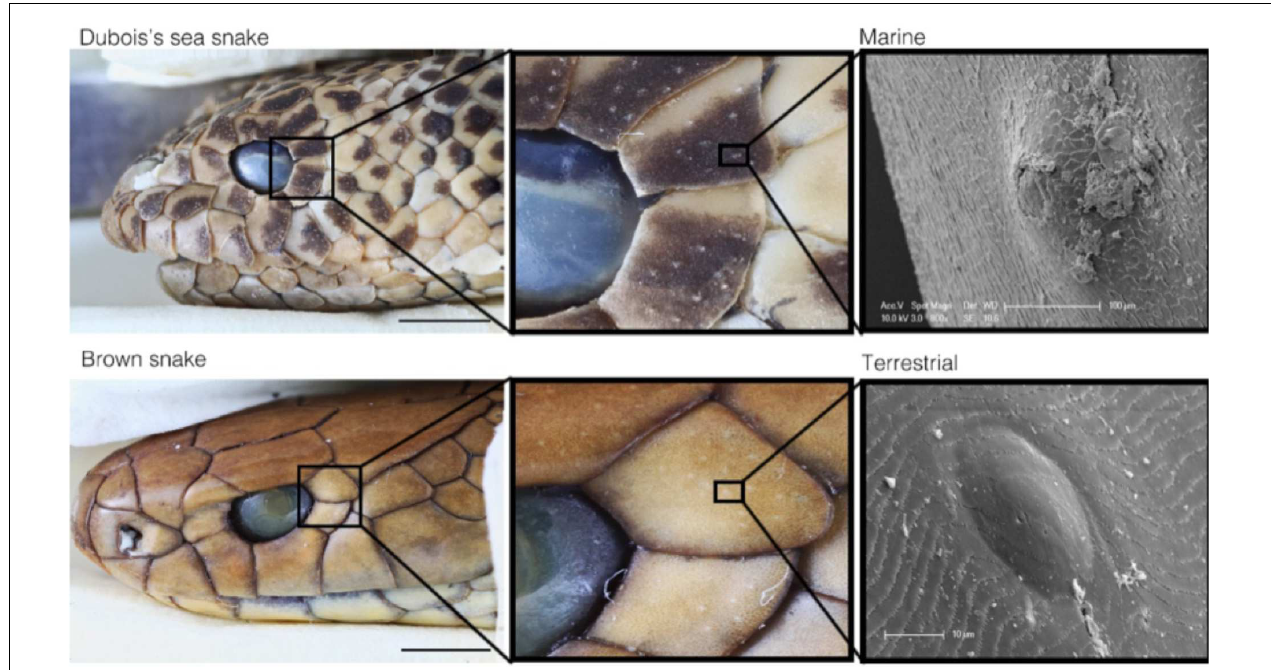
FIGURE 3 | Comparison of small scale organs, termed ‘scale sensilla,’ in fully-marine Aipysurus duboisii (top) and a close terrestrial relative Pseudonaja textilis (bottom) . Scale sensilla in many aquatic species are more protruding and have a higher overall coverage than in terrestrial elapids. Modified with permission from Crowe-Riddell et al.